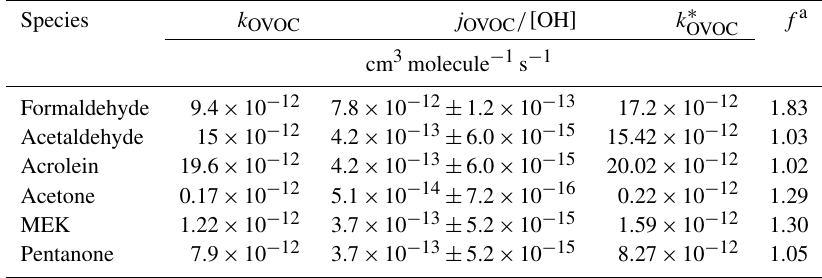
Table 1. Rate constants of OVOCs representing the combined loss to OH and photolysis.